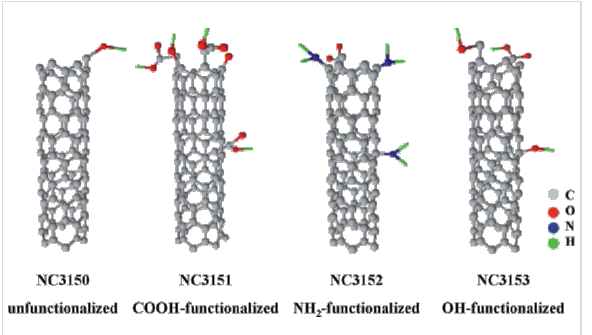
Figure 10: Unfunctionalized and differently functionalized CNTs. Reproduced with permission from [53], copyright 2010 Elsevier.